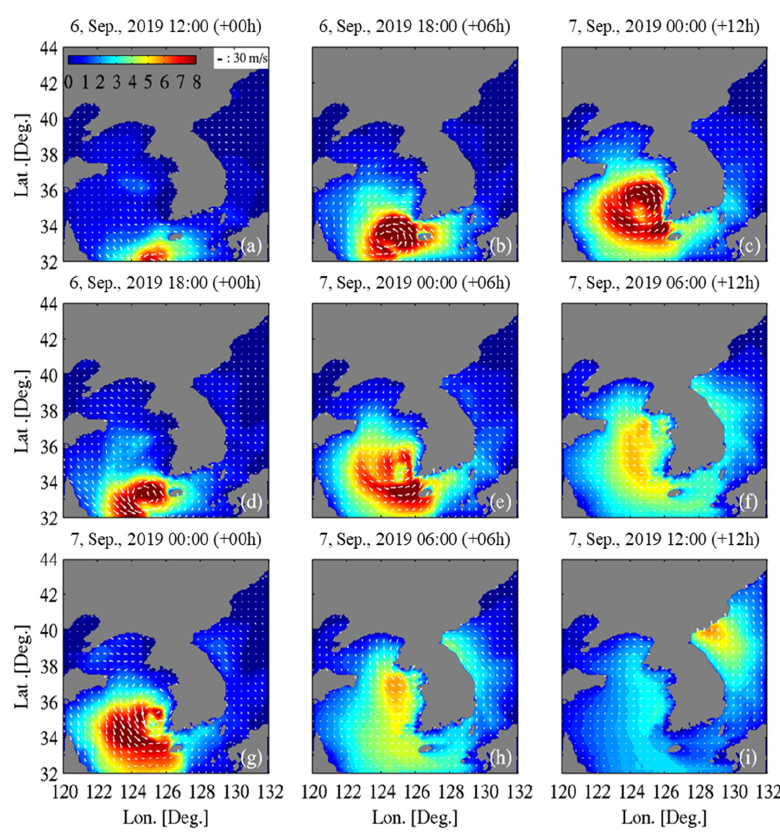
Figure 3. Simulated significant wave height and input sea wind vectors of Case00 ( β max = 1.65) in the numerical experiment results: ( a ) 6 September 2019 12:00 UTC (+00 h); ( b ) 6 September 2019 18:00 UTC (+06 h); ( c ) 7 September 2019 00:00 UTC (+12 h); ( d ) 6 September 2019 18:00 UTC (+00 h); ( e ) 7 September 2019 00:00 UTC (+06 h); ( f ) 7 September 2019 06:00 UTC (+12 h); ( g ) 7 September 2019 00:00 UTC (+00 h); ( h ) 7 September 2019 06:00 UTC (+06 h); ( i ) 7 September 2019 12:00 UTC (+12 h).